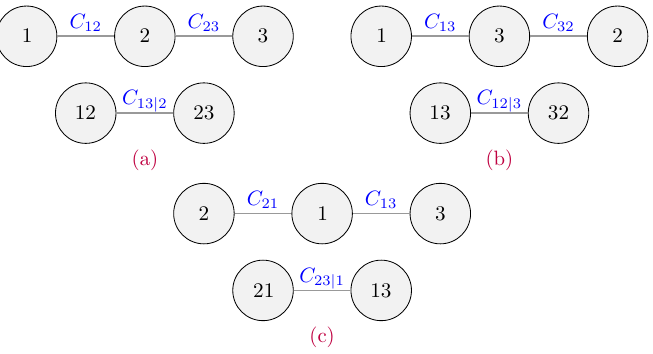
Figure 1. R-vine structures for 3